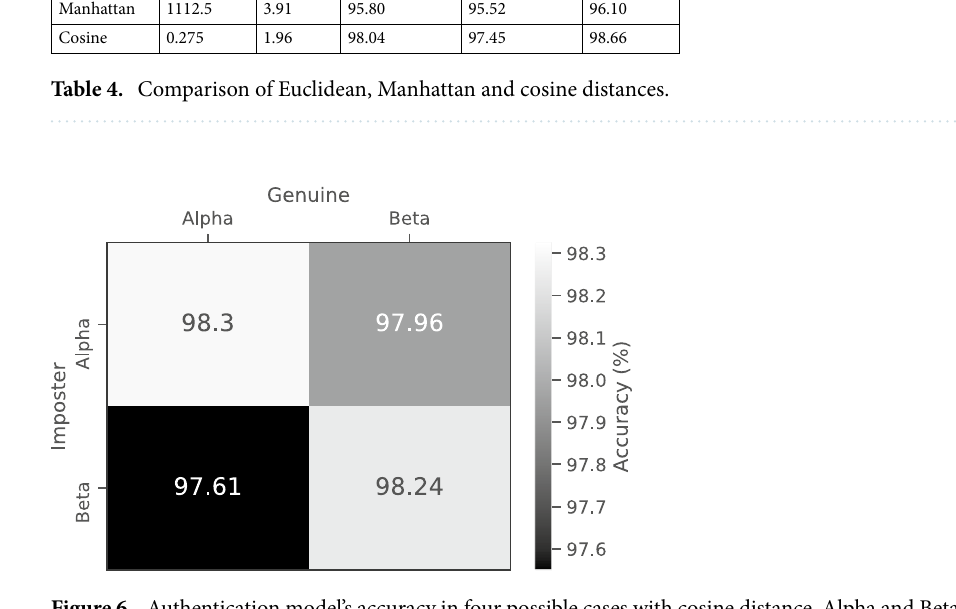
Figure 6. Authentication model’s accuracy in four possible cases with cosine distance. Alpha and Beta labels indicate whatever the data was used in the training and testing phase or